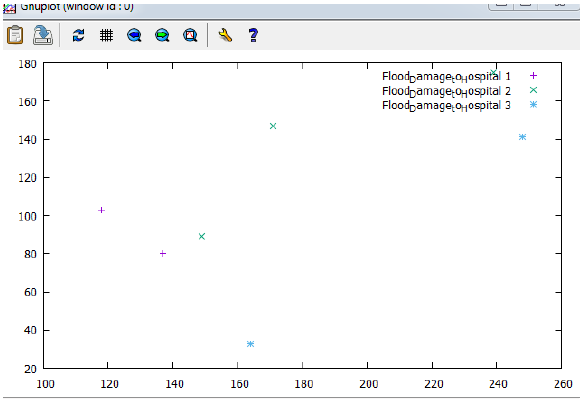
Figure 7. Disruption to Healthcare CI Due to Flood.